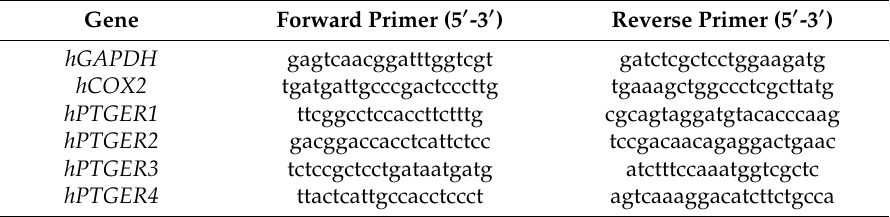
Table 1. Primer sequences for human (h) genes of